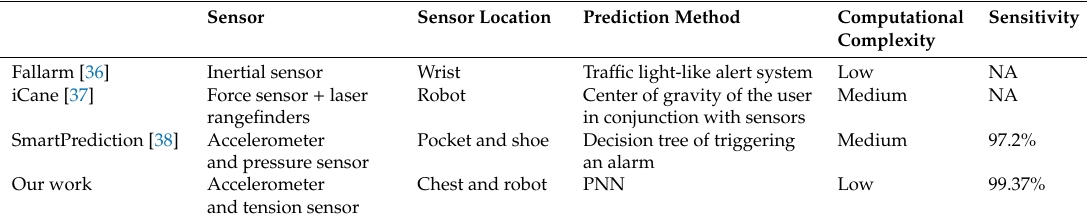
Table 2. Comparison between the proposed algorithm and state-of-the-art fall prevention systems. PNN: probabilistic neural